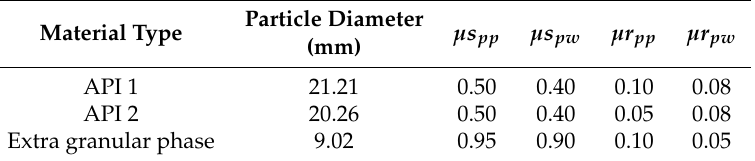
Table 2. DEM simulation parameters.